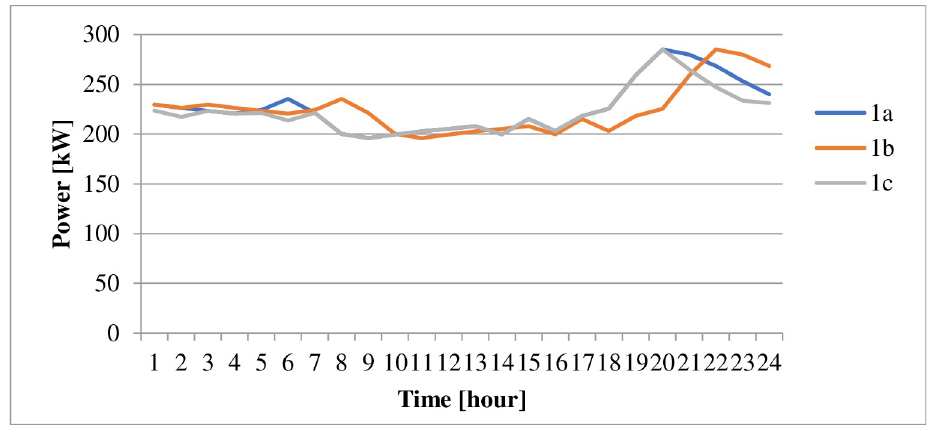
Fig 4. Load profiles within 24 hours–case